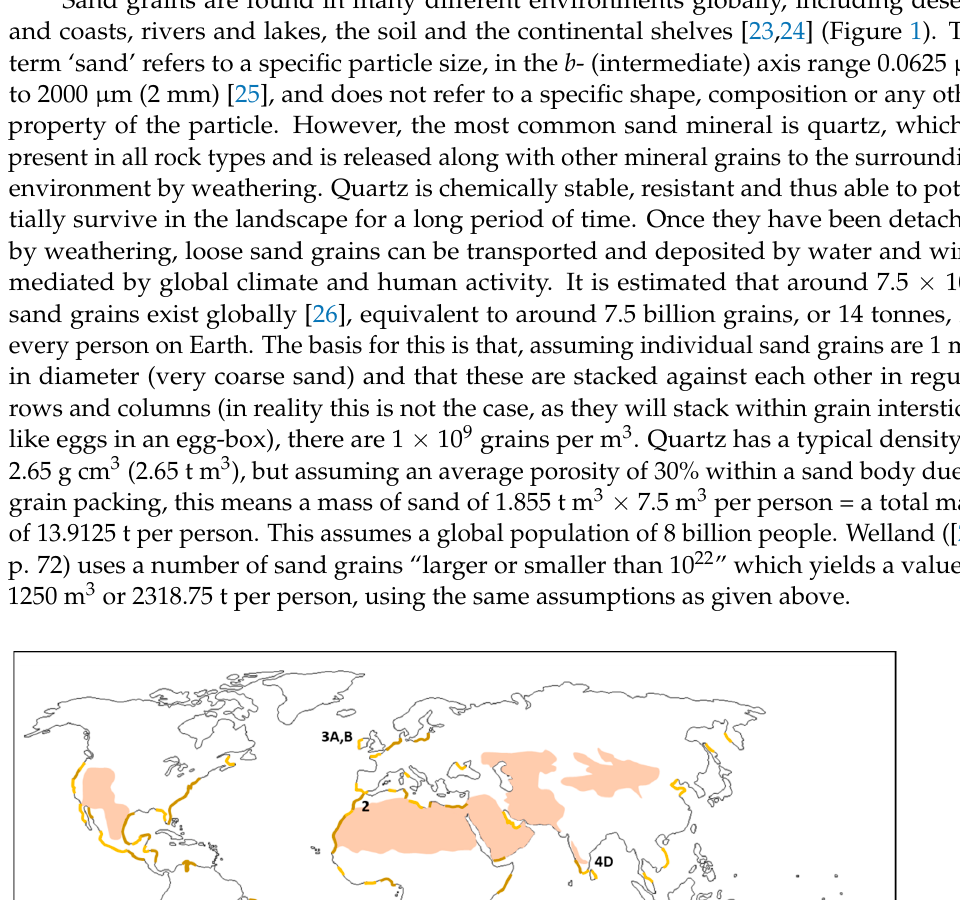
Figure 2. Examples of sand in desert dune systems on the western periphery of the Sahara desert in western Morocco. ( A – C ) Migrating draa and superimposed ripples, showing how these landforms on different scales are superimposed upon and move at different rates and directions, ( D ) camel train within the dune system, whereby the human world negotiates the obstacles and opportunities presented to them by the migrating dunes (photos: author).